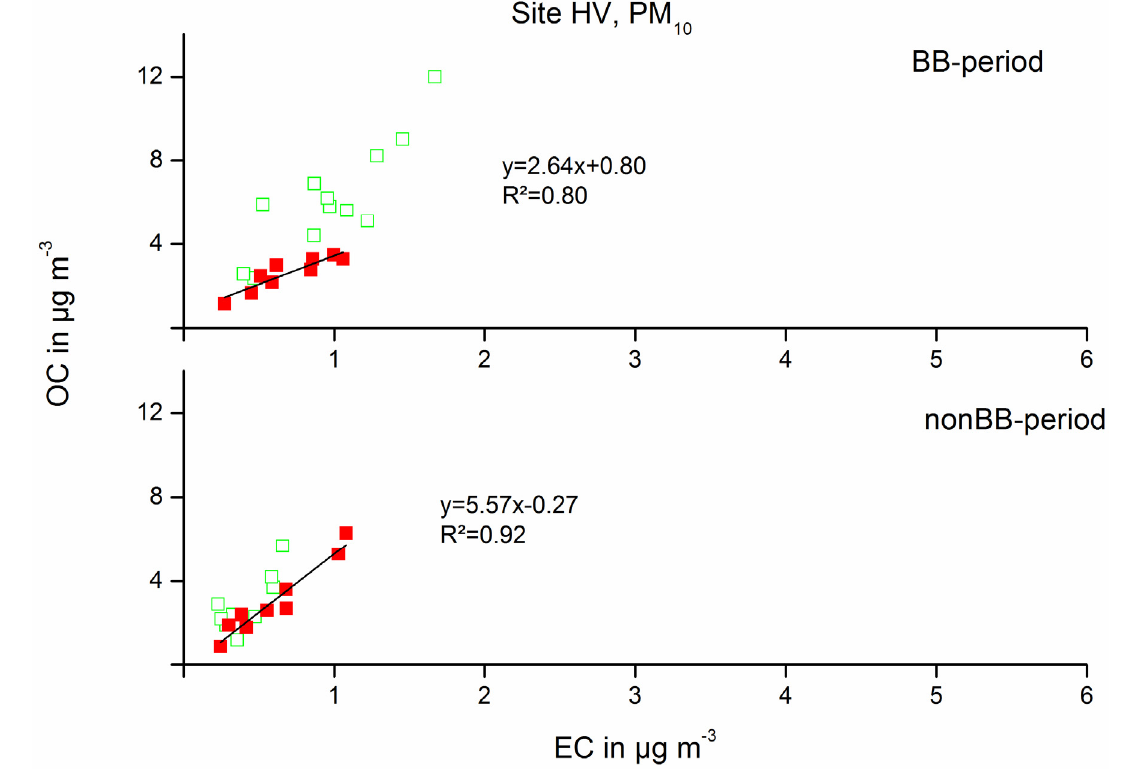
Figure A1. Evaluation of [OC/EC]